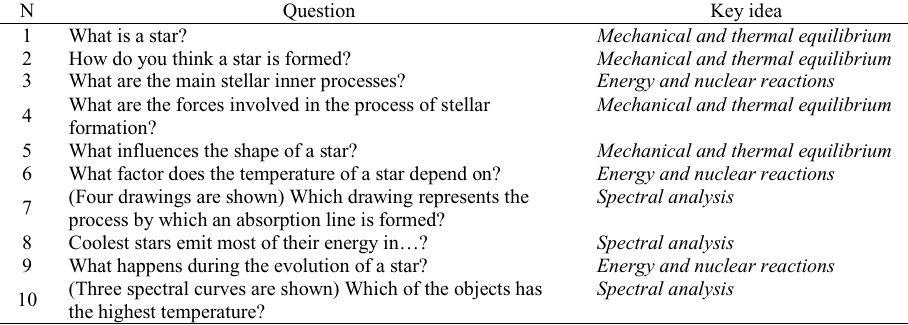
Table 2: Description of the items of the questionnaire